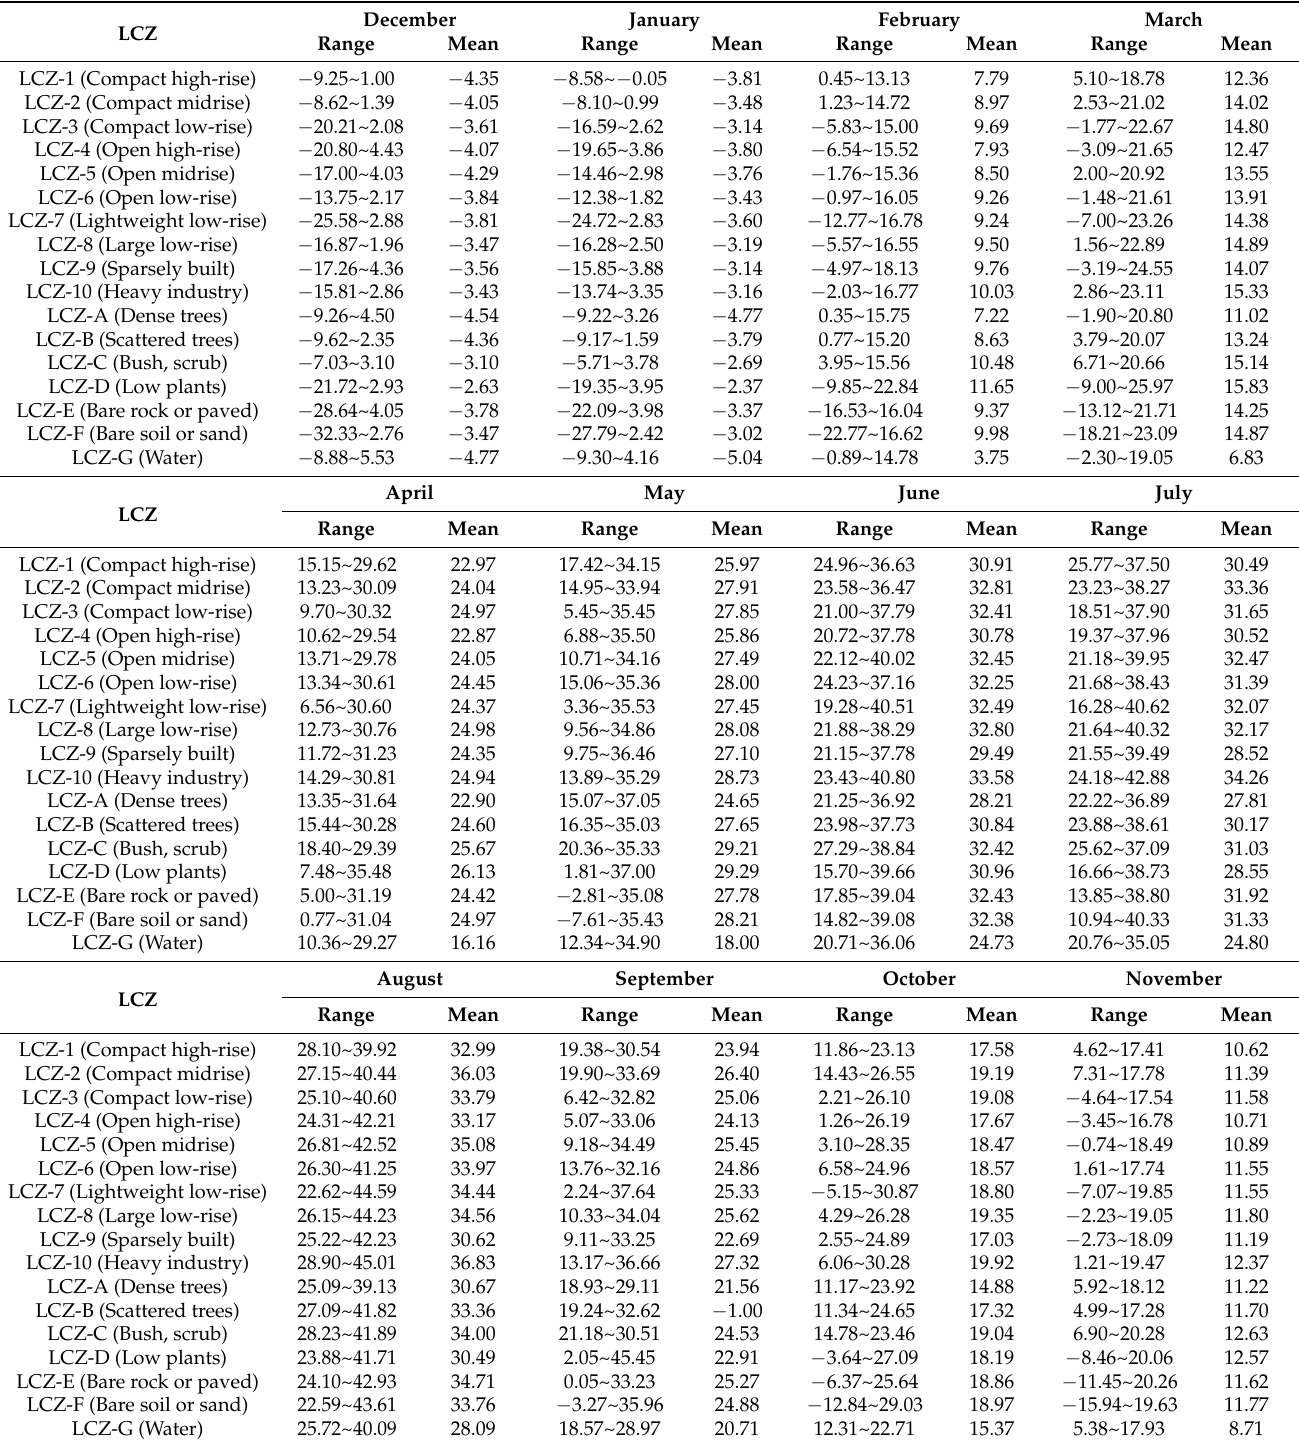
Table A2. Land Surface Temperature of Different Local Climate Zones in Different Months within Rural Context. LCZ LCZ-1 (Compact high-rise)